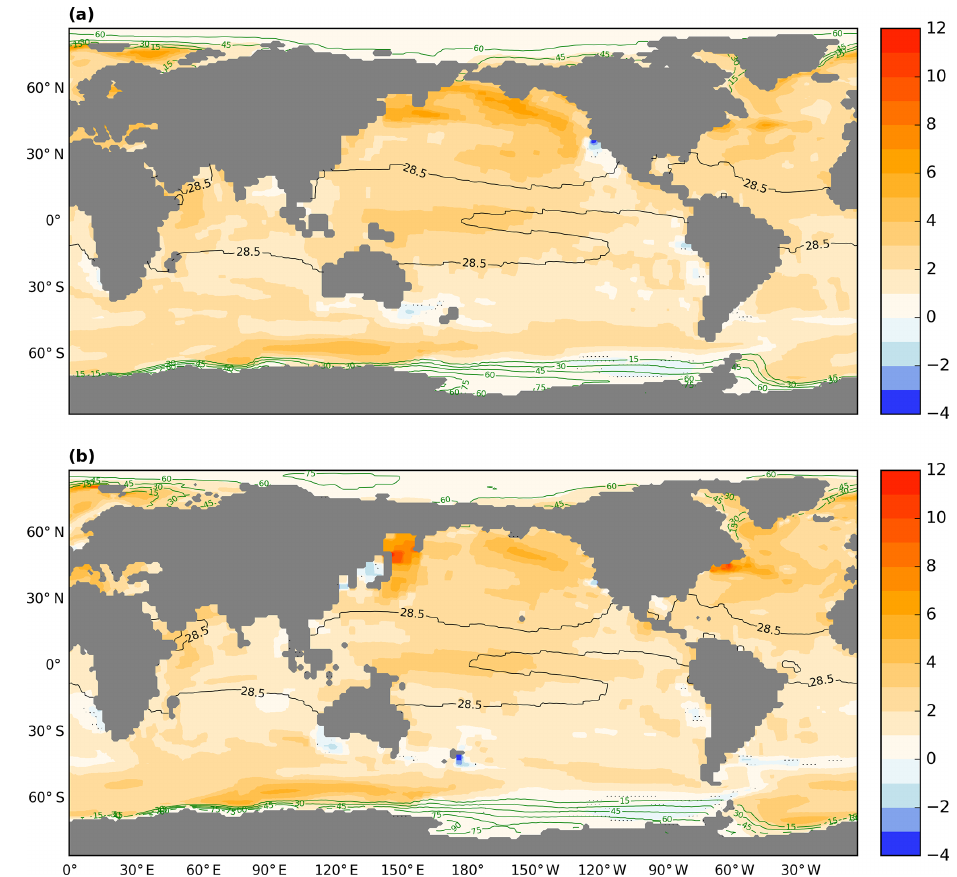
Figure 6. Comparison between mid-Pliocene SST ( ◦ C) anomalies calculated from 100 years of model output with respect to PI control simulations as obtained from COSMOS (a) PlioMIP1 and (b) PlioMIP2. Black isolines show the expansion of the equatorial warm pool in the mid-Pliocene state, while the green isolines depict absolute annual mean sea ice cover in the mid-Pliocene state. The contour interval for the sea ice isolines is 15%.